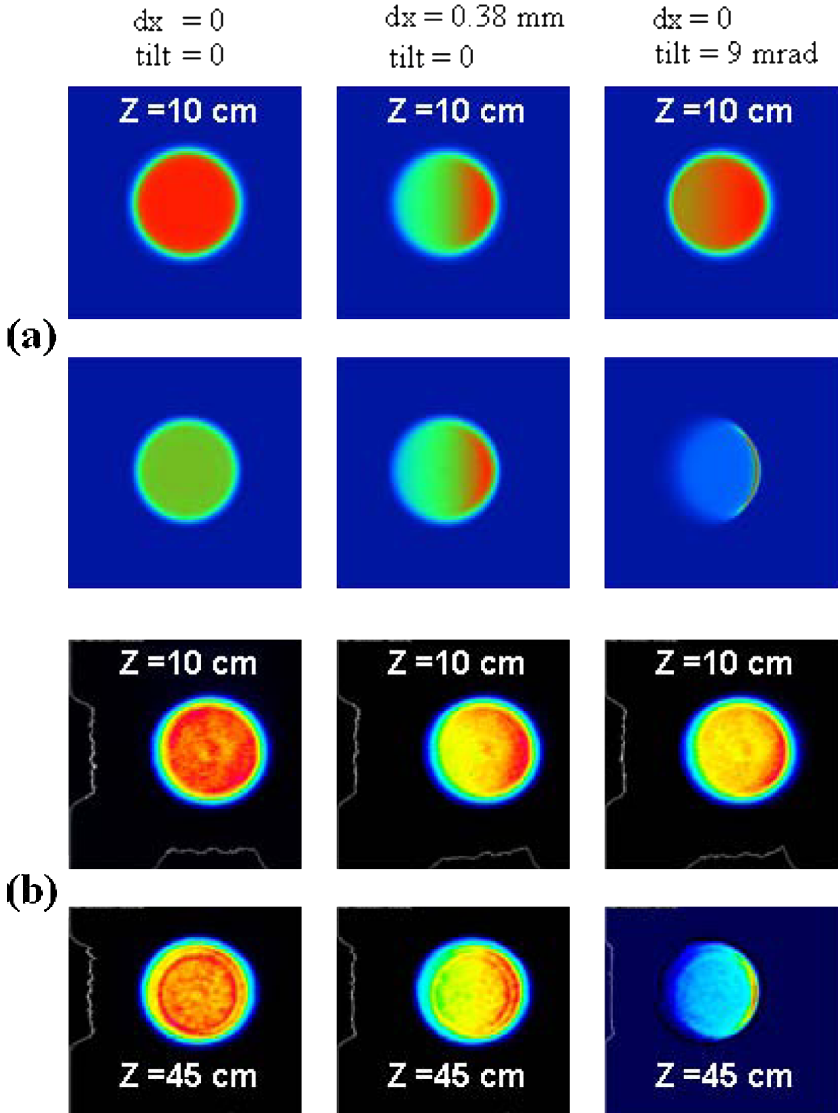
FIG. 6. (Color) Spatial beam profile at 10 and 45 cm away from the (cid:5) shaper at different alignment conditions: (a) ZEMAX simulation; (b) corresponding experimental